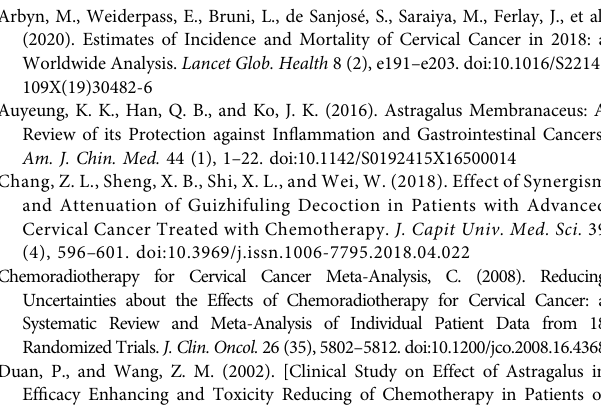
Frontiers in Pharmacology |